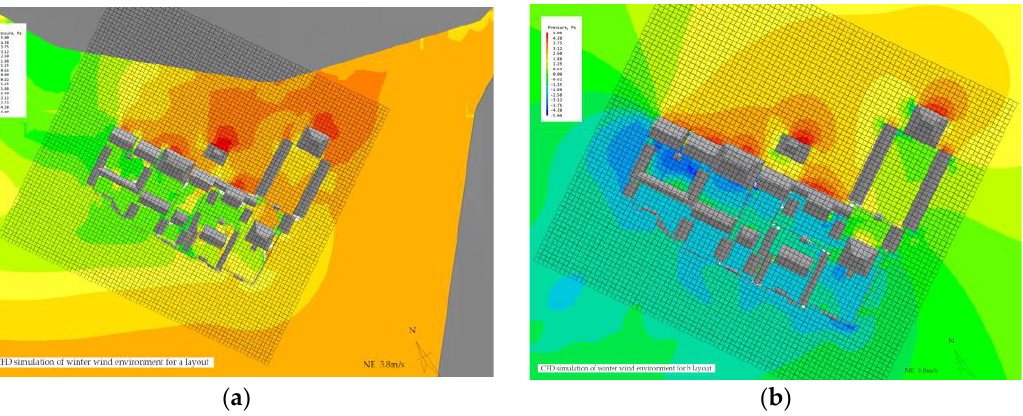
Figure 13. CFD simulation wind speed contour maps. ( a ) Wind speed cloud of Feng Shui layout in winter; ( b ) wind speed cloud of no Feng Shui layout in winter. All data presented in the figures were obtained from the CFD simulations.